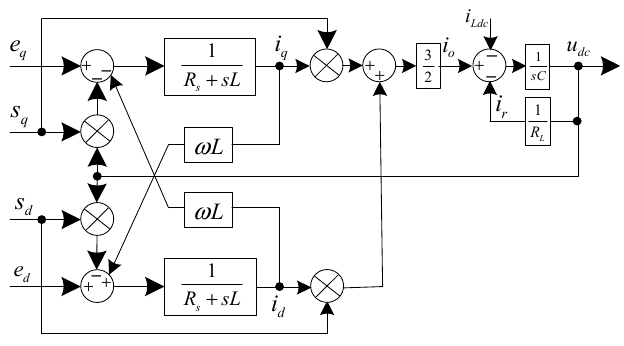
Figure 2. Modelling of the system in the dq frame.